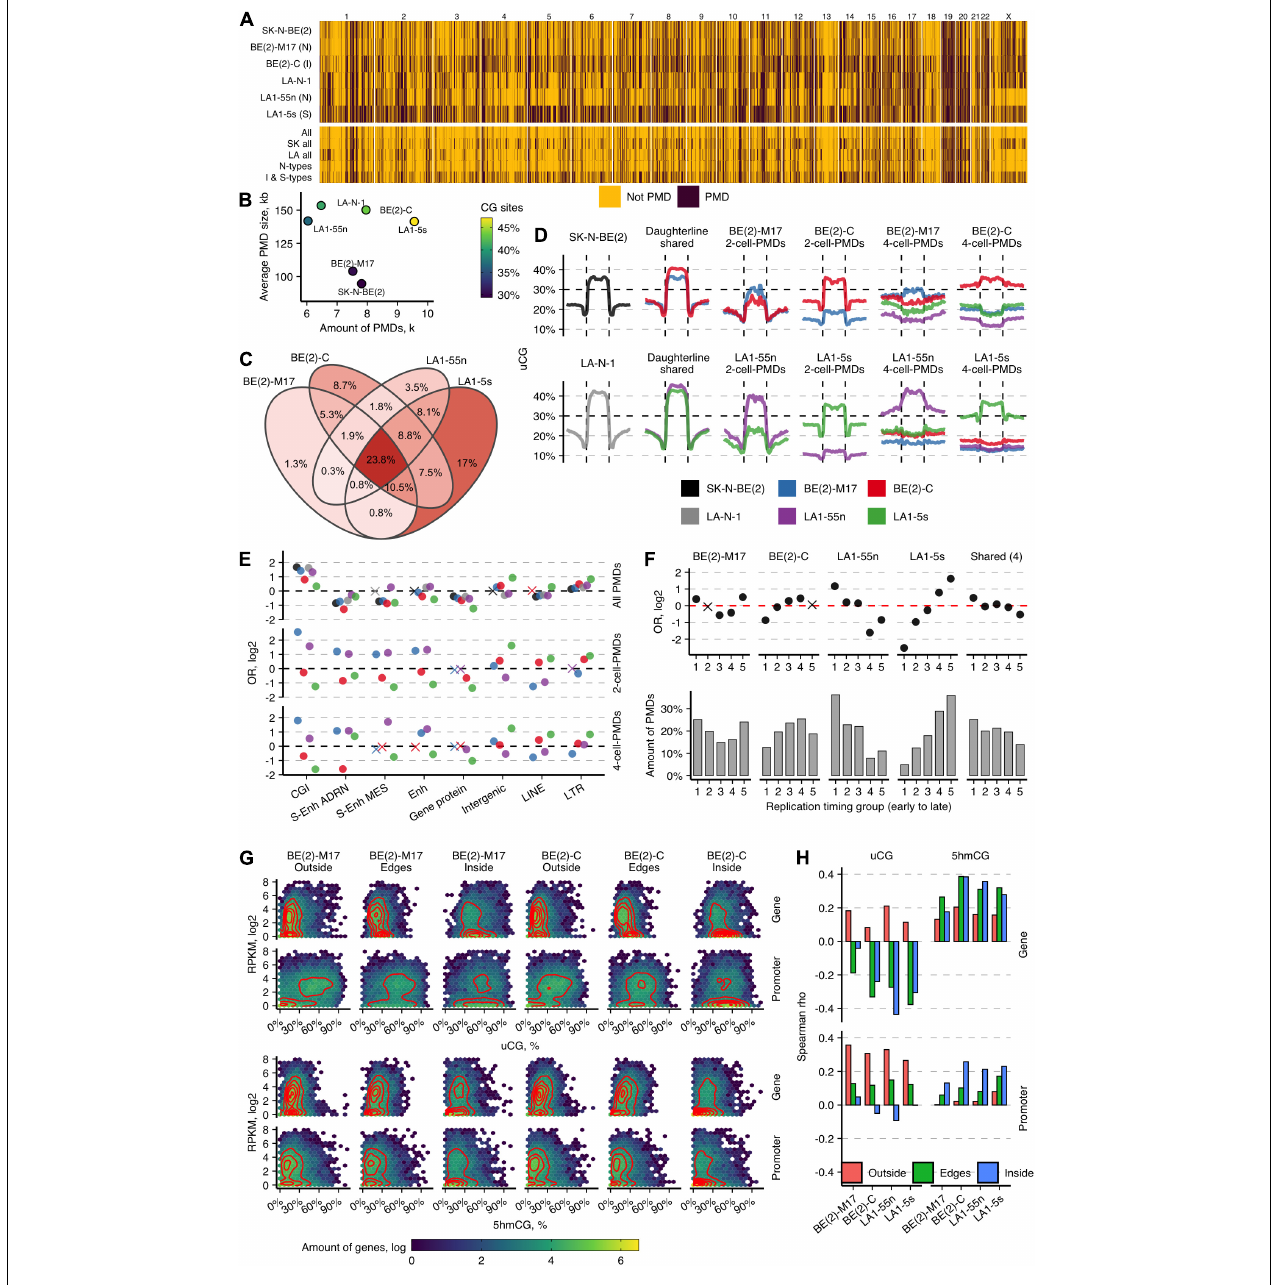
FIGURE 4 | Large-scale genome organization of NB cell types predicts cell identity. (A) Genome-wide maps of PMD distribution in normoxic NB cell lines. Below are shown the maps of the overlapping PMD regions for the indicated cell lines. SK all and LA all represent the SK-N-BE(2) and LA-N-1 groups, respectively. (B) Distribution of PMD amounts (in thousands, k) and their average sizes in NB cell lines. (C) Venn diagram for the overlap of PMDs in 10-kb tiles for the subpopulations of the SK-N-BE(2) and LA-N-1 groups. Percentage indicates the amount of tile overlap between given subpopulations. (D) uCG profiles across PMDs and 50-kb upstream and downstream regions of the parental cell lines SK-N-BE(2) and LA-N-1; PMDs shared between the subpopulations of the SK-N-BE(2) and LA-N-1 groups; the unique 2-cell-PMDs; and the unique 4-cell PMDs identified among the four subpopulations. The line at 30% indicates a uCG threshold used for PMD identification. PMDs were divided into 20 equally sized non-overlapping windows and average uCG fractions were computed for each given cell line. (E) OR from Fisher’s exact test for enrichment of all PMDs and the unique 2-cell-PMDs and 4-cell-PMDs across various genomic features. Non-significant estimates ( p ≥ 0.05) are marked with “X.” (F) Enrichment OR and amounts of the unique 2-cell-PMDs and the shared for all four subpopulation PMD bins (23.8%, C ) in five replication timing regions. (G) Heatmaps and two-dimensional density estimates for uCG/5hmCG fraction and expression data distributions for genes localized outside of PMDs (Outside), within PMDs (Inside), and crossing PMD boundaries (Edges) in BE(2)-M17 and BE(2)-C. (H) Spearman’s correlation between uCG or 5hmCG fractions and RNA data as a function of gene location within or outside of PMDs or overlapping PMD boundaries. Promoters are defined as the 2-kb regions upstream